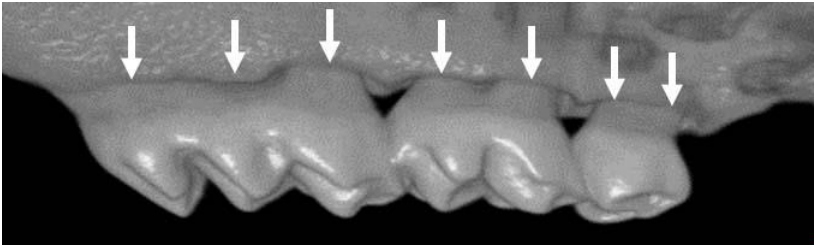
Figure 2. Measurement of alveolar bone loss as the linear distance between the cementum-enamel junction (CEJ) and the alveolar bone crest (ABC). Arrows indicate the measurement site.